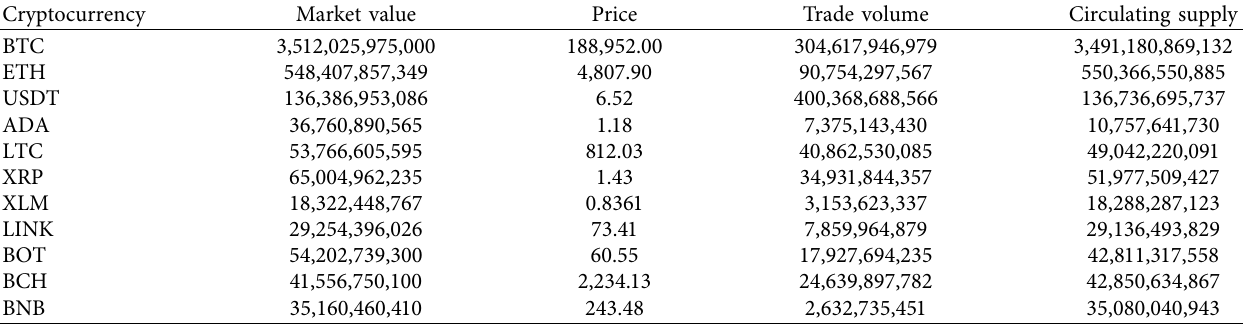
Table 1: Information for the top 10 cryptocurrencies (RMB).